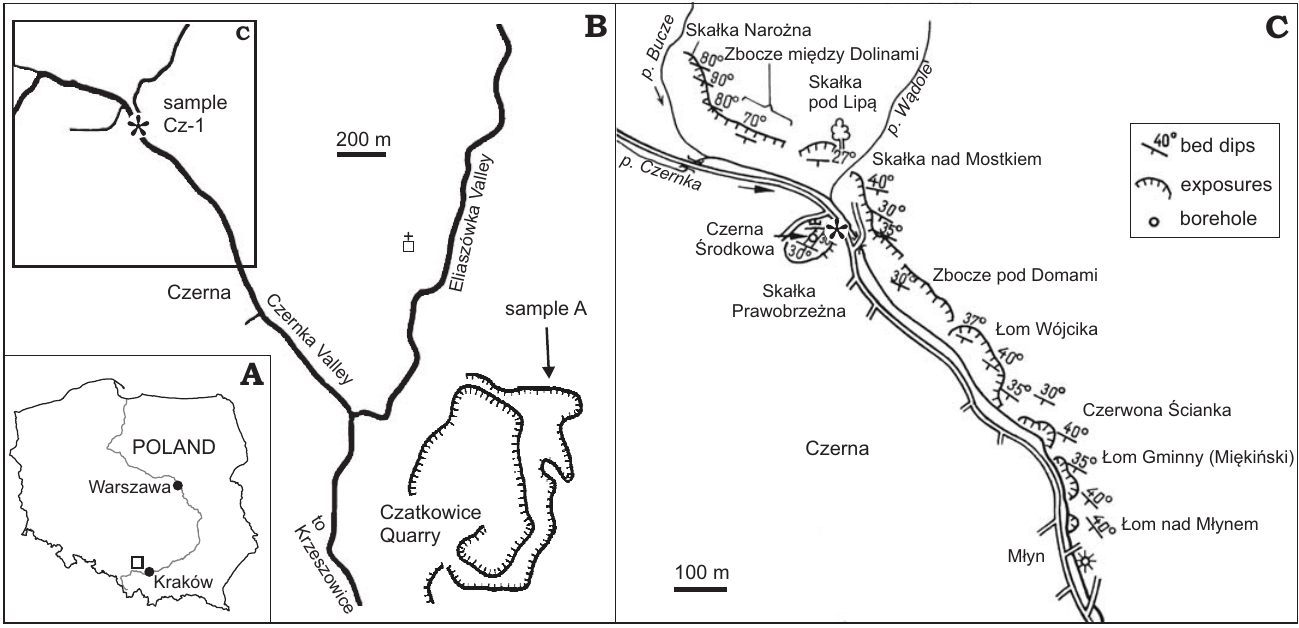
Fig. 1. A . Position of the study area (square) against the outline of Poland and Vistula River. B . Approximate positions of the studied samples: sample A from Czatkowice Quarry (arrow) and Cz-1 from Czerna (asterisk); black lines, paved roads, open square with a cross, Carmelites’ Monastery. C . Close-up of the area at NW Czerna (marked in B) showing the outcrops of Mississippian limestone accessible around 1970; asterisk, possible position of sample Cz-1; from Zaj ą czkowski (1975),